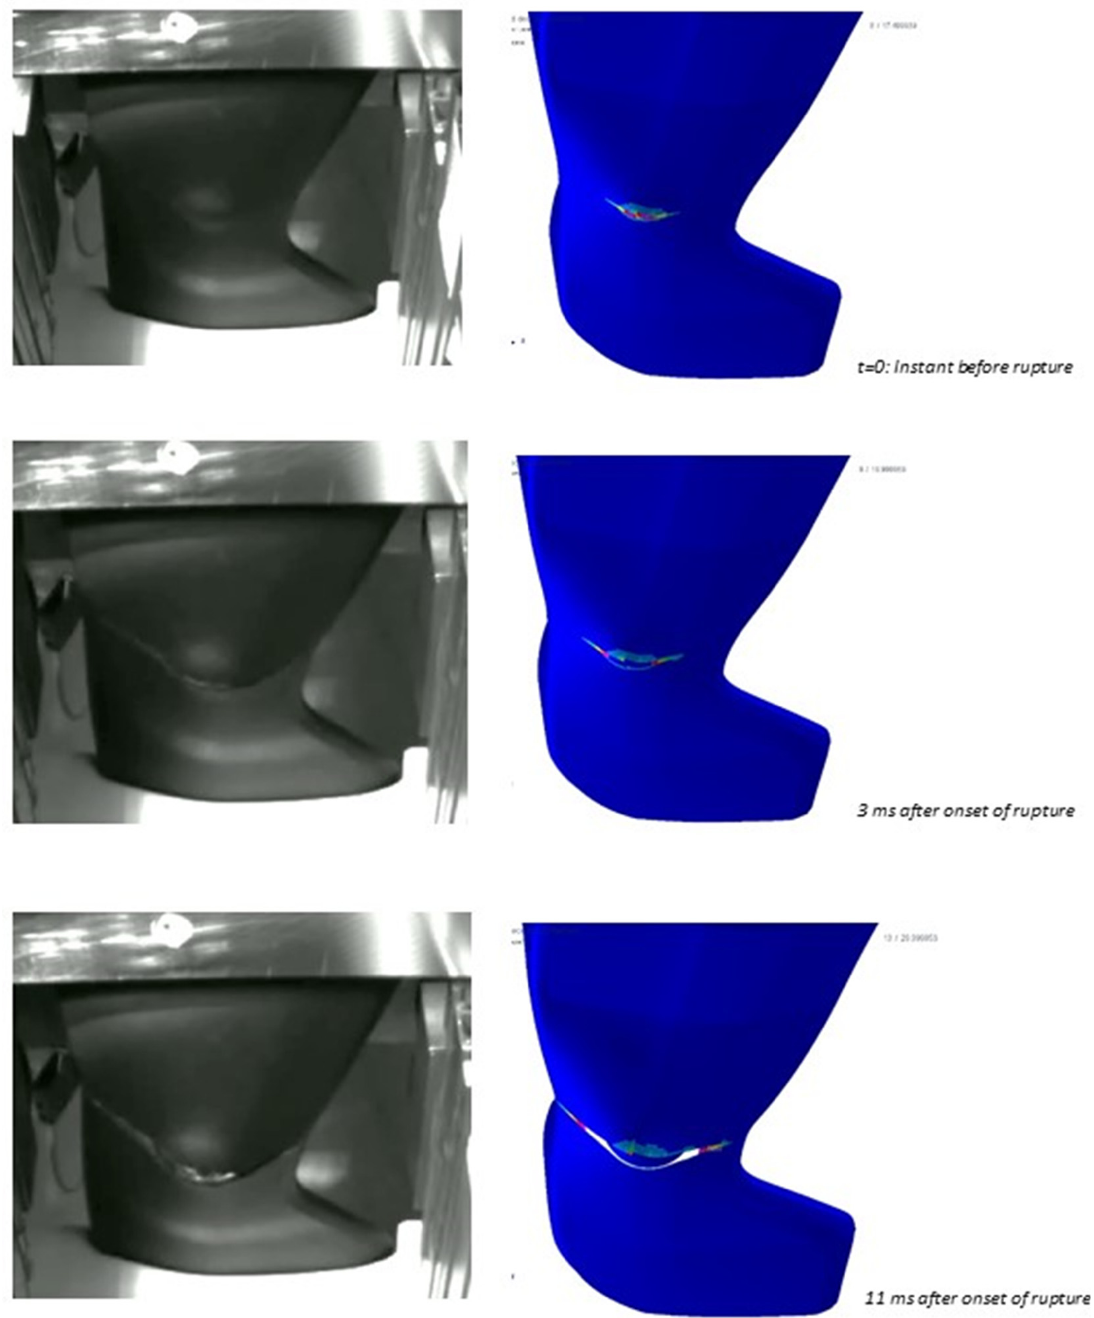
Figure 9. Comparison of fracture modes predicted by simulations ( right ) and observed experimen- tally ( left ) at different time instants during the impact sequence. Images refer to the 65 mm diameter impactor, impact speed of 2 m/s, and part thickness of 3.2 mm. Pictures from the experimental test provided by SMP GmbH, Bötzingen, Germany.